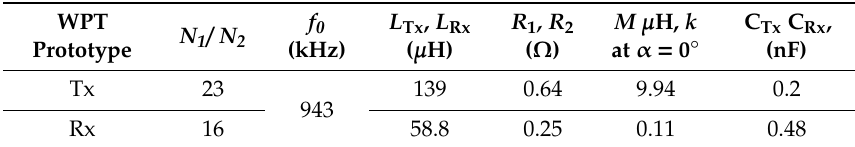
Figure 13. Input voltage (CH1) and output voltage (CH2) of first design: ( a ) α = 0°; ( b ) α = 30°; ( c ) α = 60°; ( d ) α = 85°. The chosen design had low fluctuations of mutual inductance while rotating the Rx coil. The measured and simulated mutual inductances are presented in Figure 14. Simulated mutual inductance is always larger than measured mutual inductance. The simulations gave ideal values of